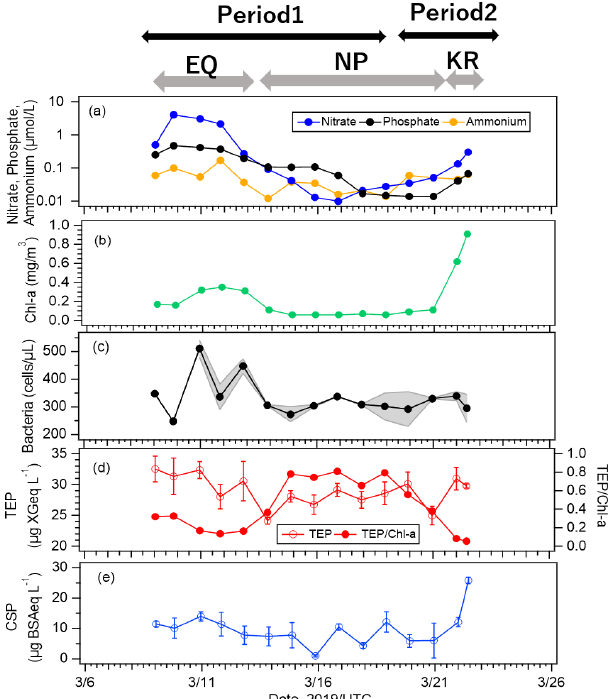
Figure 6. Time series of concentrations of (a) nutrients, (b) Chl- a , (c) bacteria, (d) TEPs and normalized TEP obtained by divid- ing TEP concentration by Chl- a concentration, and (e) CSPs at the equatorial upwelling region (EQ), North Pacific subtropical region (NP), and south of Kuroshio Extension (KR). The y axis in Fig. 6a is displayed as logarithmic. The shade ranges in Fig. 6c are shown for samples where duplicate measurements were made. The error bars represent 1 standard